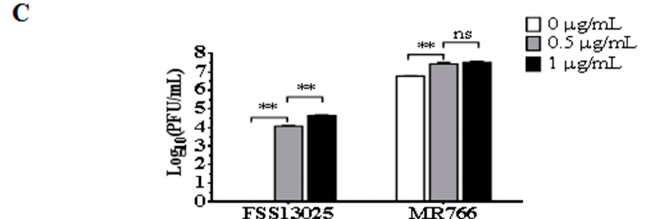
Figure 3. Doxycycline dose-dependent production of cDNA-derived ZIKV. Vero cells in 12-well plates were co-transfected with 1 µ g of pTight-ZIKV/MR766 or pTight-ZIKV/FSS13025 DNA and 1 µ g of an empty vector or pTet-On. The DNA-transfected Vero cells were cultured with different concentrations (0, 0.5, and 1 µ g/mL) of doxycycline. The viral E protein in the DNA-transfected cells was determined by IFA at 3 d p.t. (for MR766) or 6 d p.t. (for FSS13025). The supernatants harvested at 3 d p.t. (MR766) or 6 d p.t. (FSS13025) were used to infect naïve Vero cells. CPE formation was recorded and the E protein was detected by IFA in the virus-infected cells at 3 d p.i. Infectious virus titers were quantified by a limiting dilution and plaque assay in the same way as Figure 3. ( A ) Determination of the E protein in Vero cells co-transfected with pTight-ZIKV/MR766 DNA and vector or pTet-On or infected with cDNA-derived ZIKV/MR766 virus by IFA. CPE formation was also documented in the cDNA-derived ZIKV/MR766 virus. ( B ) IFA detection of the E protein in Vero cells co-transfected with pTight-ZIKV/FSS13025 and pTet-On DNAs or infected with cDNA-derived ZIKV/FSS13025 virus. CPE formed by the cDNA-derived ZIKV/FSS13025 virus is shown in the middle. The images of (A) and (B) were taken under 200 magnification. ( C ) Doxycycline dose-dependent production × of cDNA-derived ZIKV between the pTight-ZIKV/MR766 and pTight-ZIKV/FSS13025 DNAs. The supernatants from the DNA-transfected Vero cells as described in ( A , B ) were 10-fold serially diluted and were used for plaque assay. Infectious ZIKV titers were converted from plaque numbers and calculated as plaque-forming units per milliliter (PFU/mL). Values represent the means standard ± deviations (SD) from three independent experiments. Statistical significance was analyzed by Student’s t -test: ** p < 0.01. ns indicates no significant difference.